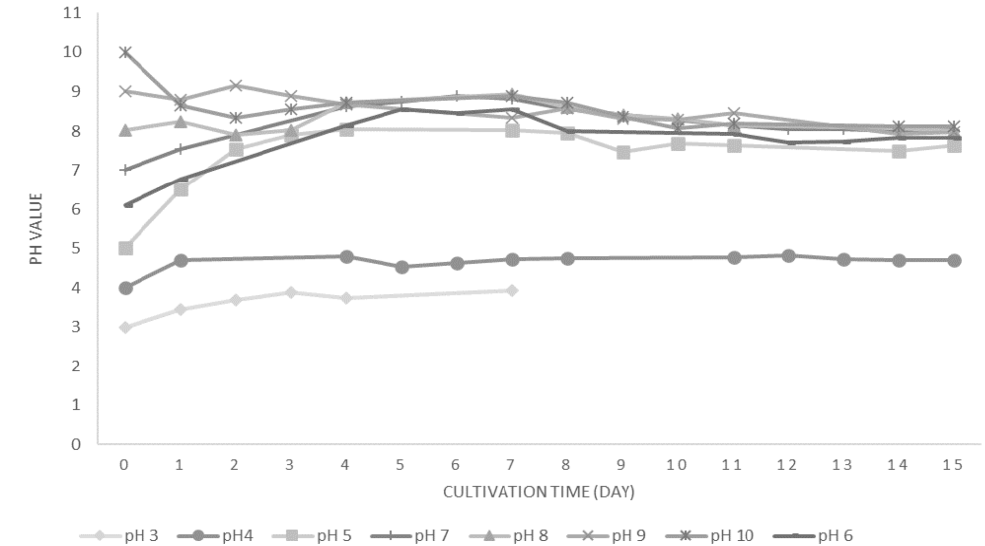
Figure 4. Development of the pH value at different initial pH values when cultivating D. salina at light intensity of 3000 LUX and 50 g/L NaCl.